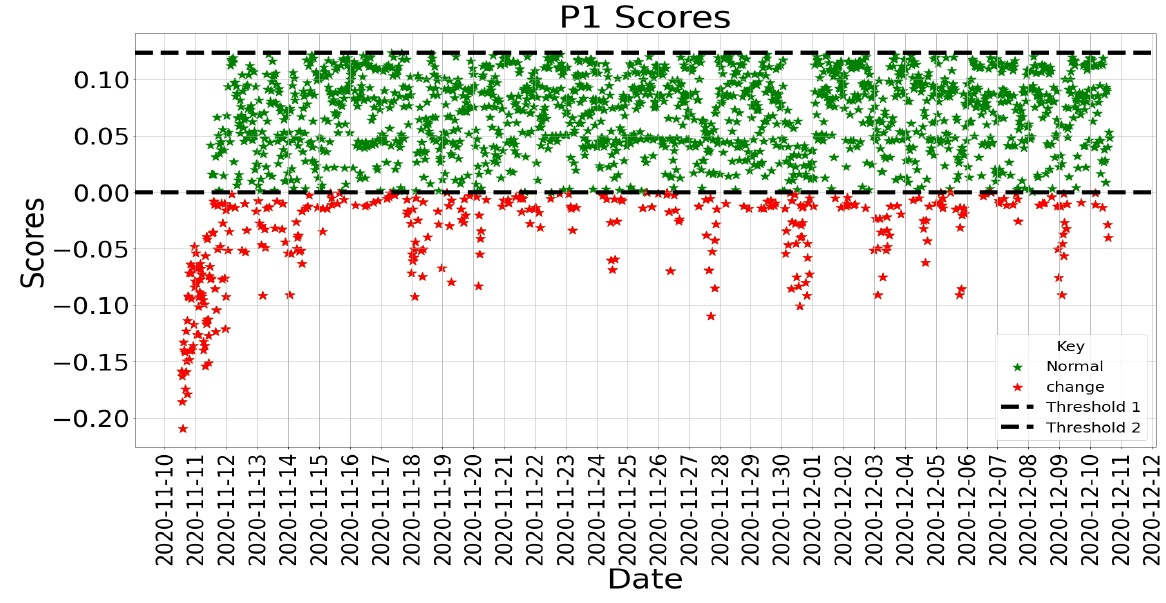
Figure 22. Scores from Decision Function.